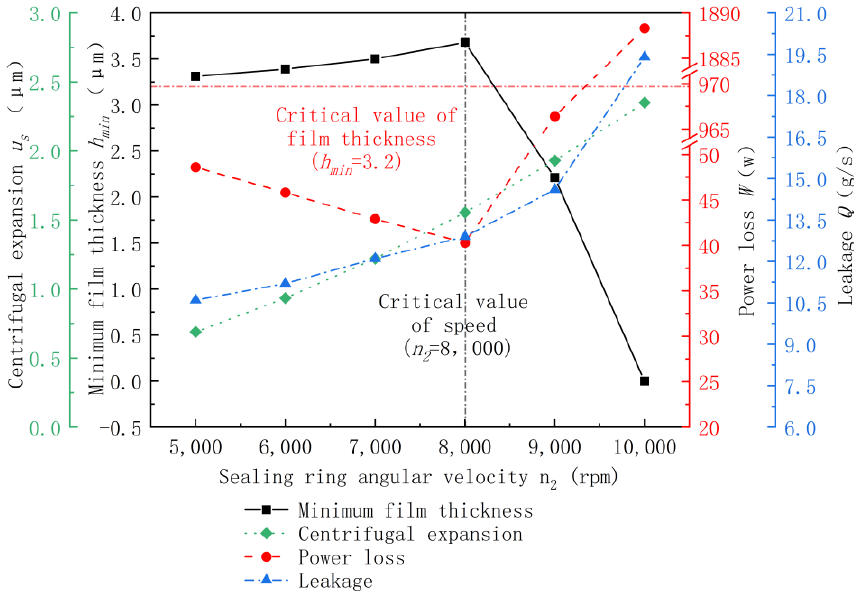
Figure 11. Effects of outer rotor speed on sealing performance.